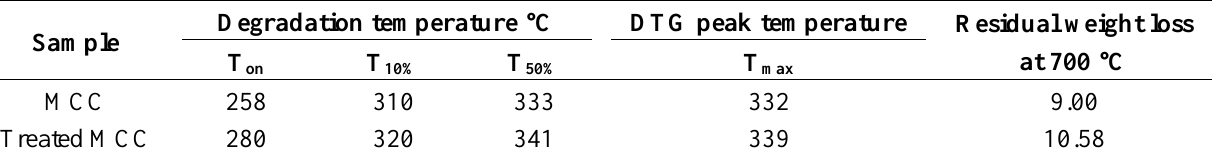
Table 6. Thermogravimetric analysis of untreated and treated